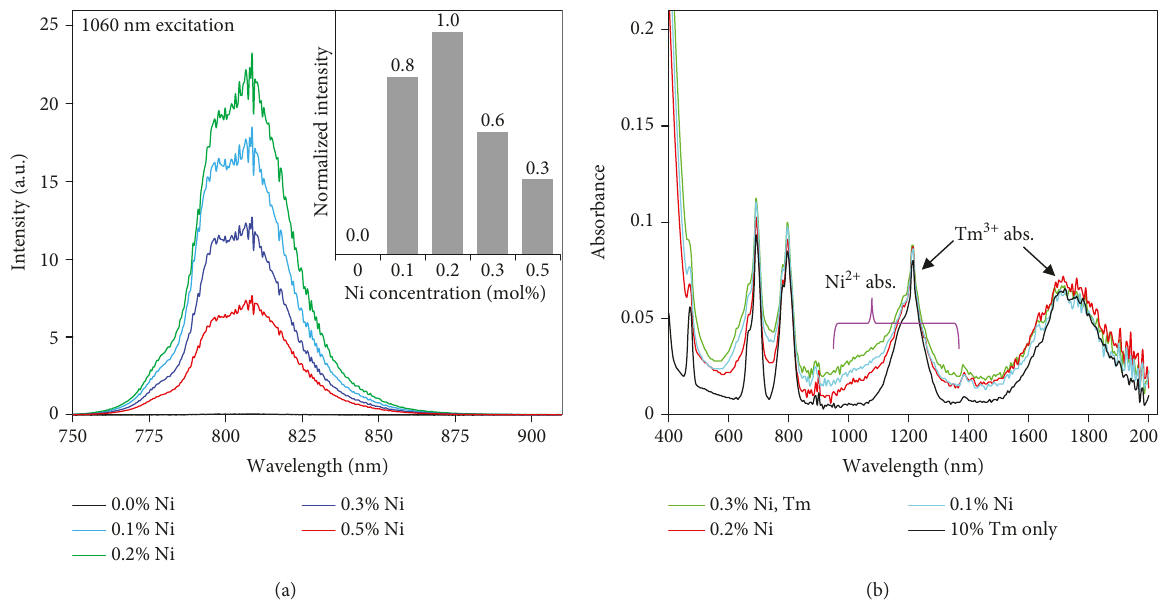
Figure 6: (a) UC emission and (b) absorption spectra of the CaTi in (a) shows the variation of the integrated UC emission intensities with Ni 2+ ion concentration.